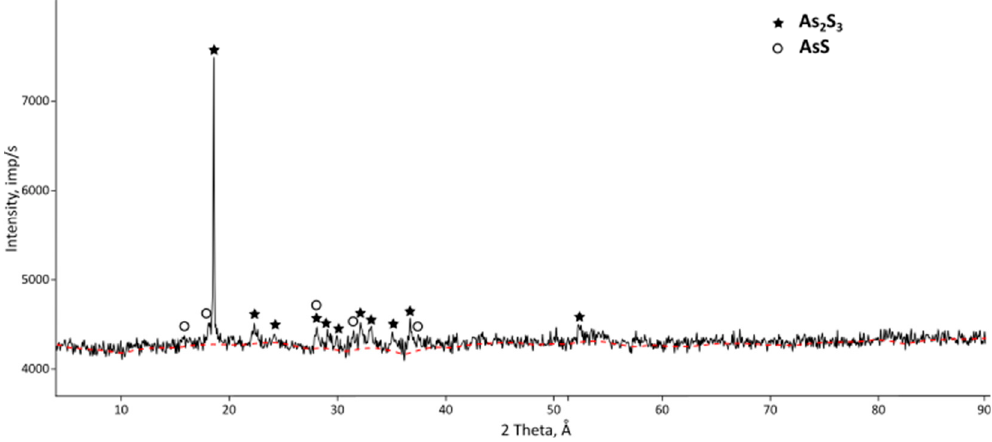
Figure 3. X-ray patterns of arsenic condensate.